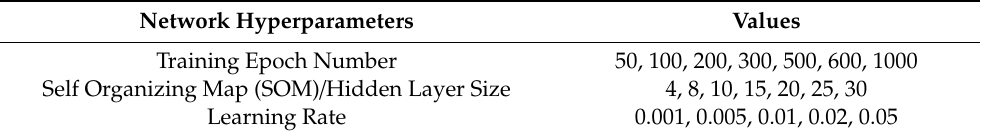
Table 3. Neural network hyperparameter values that were tested by a genetic algorithm (GA) for the architecture optimization of the classifiers that were